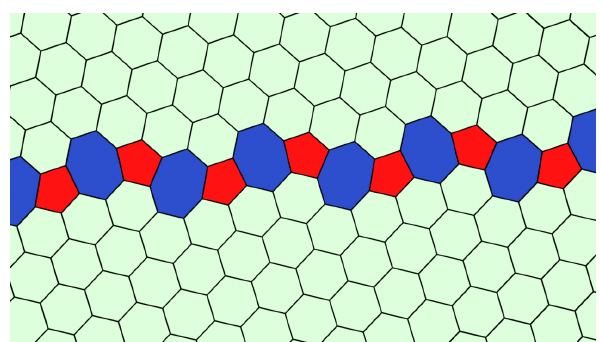
Figure 10: Two misaligned 2D graphene structures come together in a grain bound- ary. Bound pairs of 5-rings (red) and 7-rings (blue) form the dislocations, which are stacked together to create a "seam" between the two